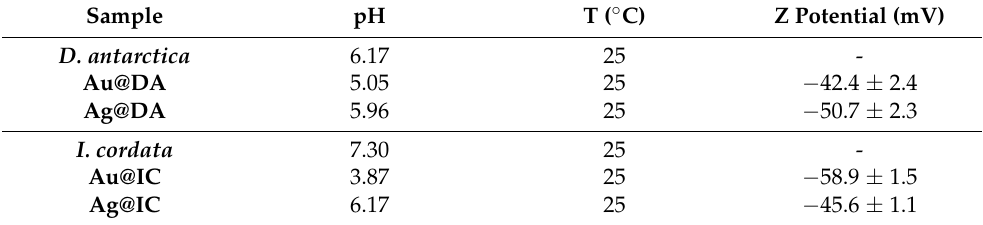
Table 2. pH and Z potential measurements of the extracts and gold and silver nanoparticles synthesized. Sample